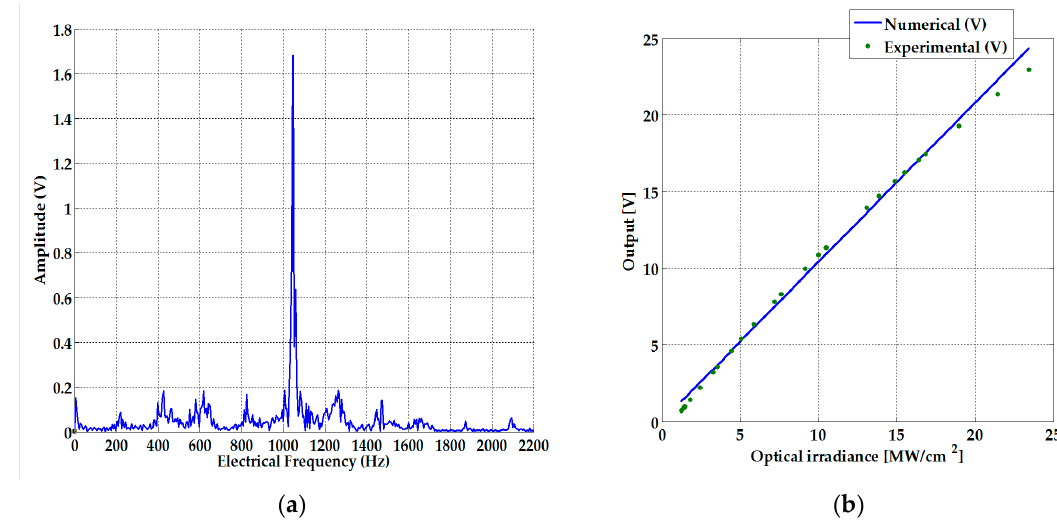
Figure 10. ( a ) Fourier spectrum of the steady-state Rössler attractor signal; ( b ) Calibration curve for the sensitivity calculation.